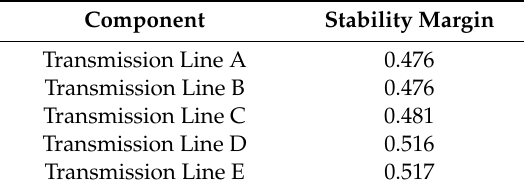
Table 1. Components with least stability margins.